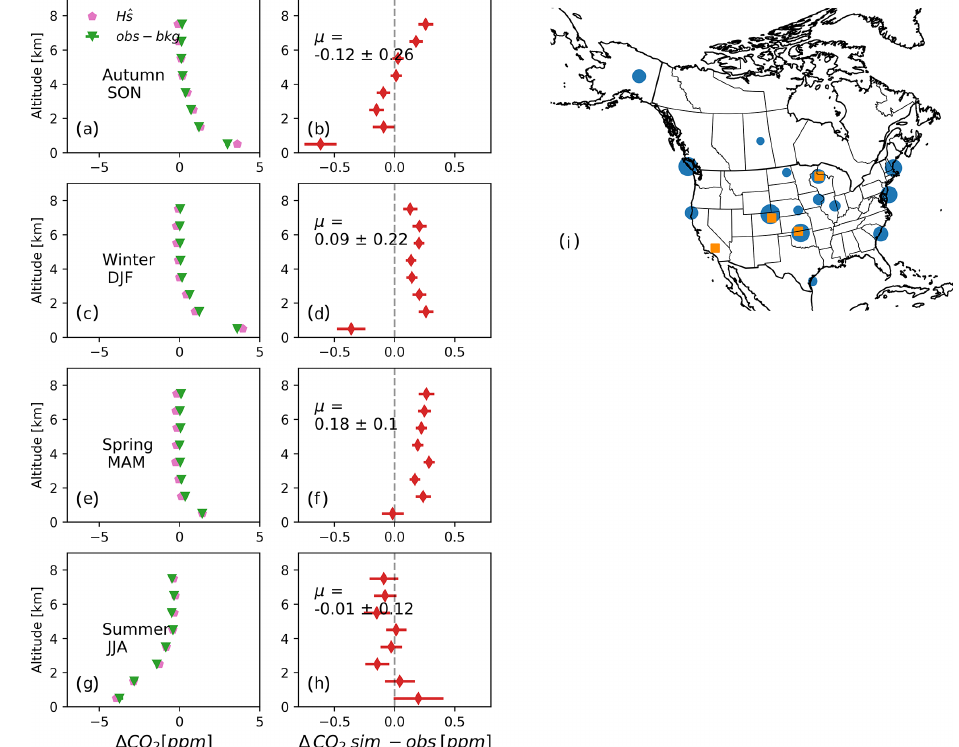
Figure 6. Simulated and observed vertical profiles from independent in situ aircraft observations collected over 2007–2015 (a, c, e, g) , showing simulated enhancements or depletion in CO 2 as a result of surface flux (pink hexagons). Additionally, the difference between observations and CT2016 background is plotted (green triangles). We report the vertically resolved and pressure-weighted bias (mean and standard deviation) between simulations and observations (b, d, f, h) . Finally, a map shows the location of aircraft profiles (blue circles in panel i ) The size of each data point indicates a relative number of samples. Additionally, AirCore profile locations are also shown (orange squares in panel i ). AirCore data are used to evaluate biases in boundary conditions in the upper 350hPa of the column and are presented in